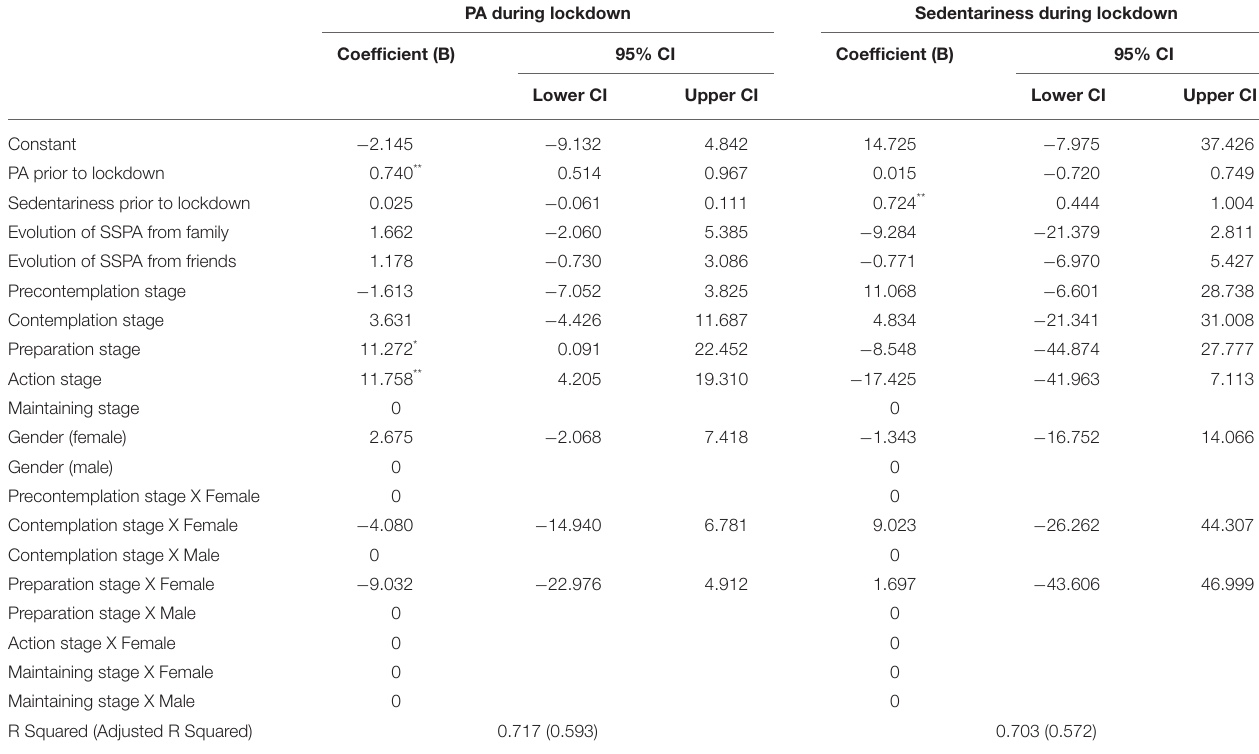
TABLE 7 | General linear model for students ( n =